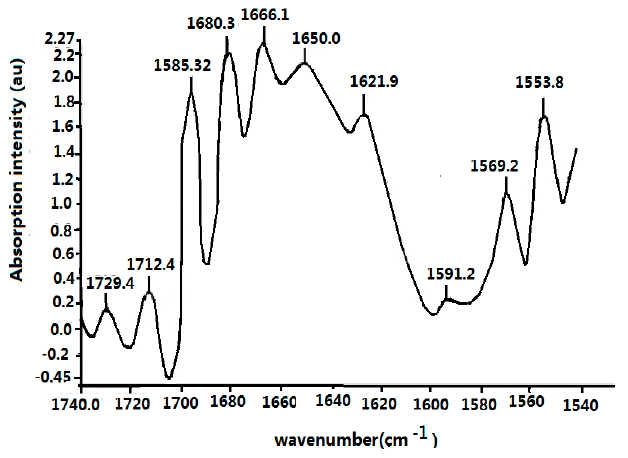
Figure 8. The infrared spectrum of collagen in 1540–1740 cm − 1 .